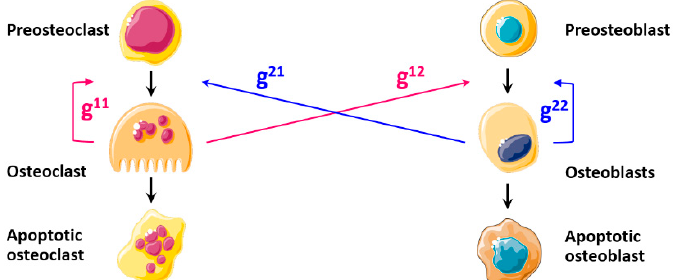
Figure 1. Diagram of the cell dynamics according to the model of Komarova et al. [14]. Here, g11 reflects the action of TGF β and g22 the action of IGF, both of them representing autocrine factors secreted by one cell to influence the other cells of its own lineage. g12 reflects the actions of TGF β and IGF, acting as paracrine factors secreted by osteoclasts to modulate osteoblasts. g21 reflects the actions of RANKL and OPG, acting as paracrine factors secreted by osteoblasts to modulate osteoclasts.